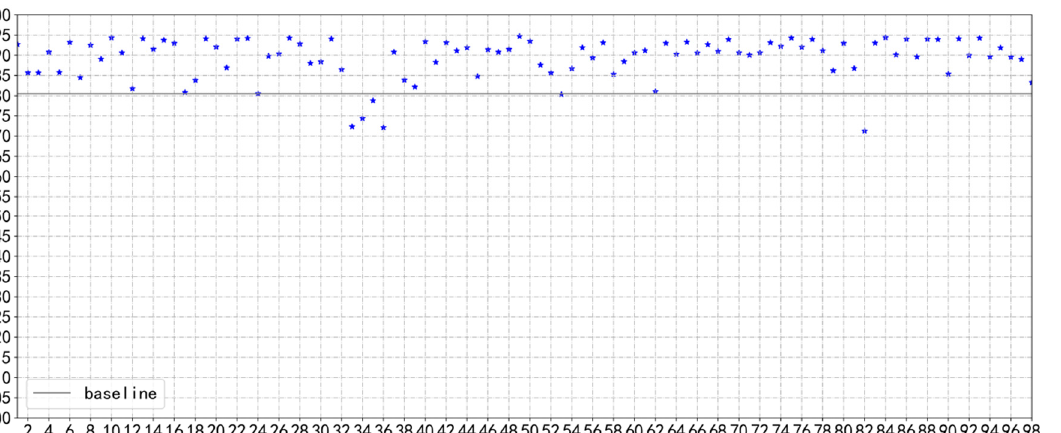
Figure 12. The ICC s of different cell voltages.